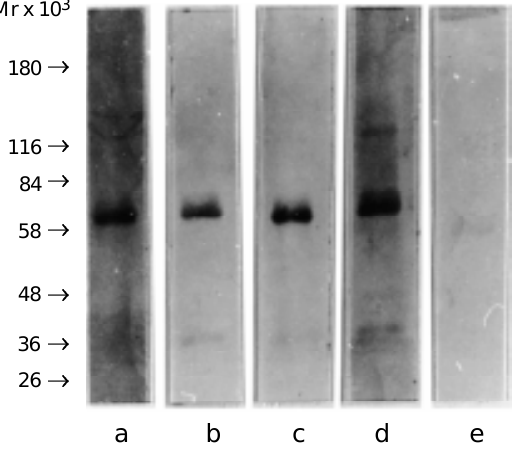
Figure 2 - Western blot analysis of the antigenic fraction present in malarial plasmas of patients infected with Plasmo- dium falciparum separated through columns of Sepharose-4B linked to anti- Proteus spp GDH(NADP + ) IgG. The electropho- retic separation was carried out in 7.5% SDS-polyacrylamide gels under reducing conditions. Immunologic detection was obtained by incubation with: a, Anti- Proteus spp GDH(NADP + ) serum/anti-IgG rabbit-per- oxidase. b, Anti-culture supernatant of Plasmodium falciparum /anti- IgG rabbit-peroxidase. c, Anti-whole-parasite ( Plasmodium falciparum) /anti-IgG rab- bit-peroxidase. d, Hyperimmune (Yanumana) serum/anti-IgG-human-peroxi- dase. e, Normal patient